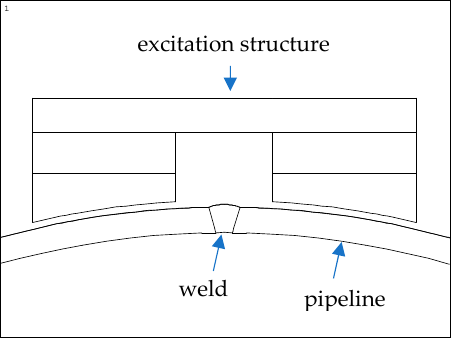
Figure 4. Crack reconstruction model under 18.8186 MPa load step.